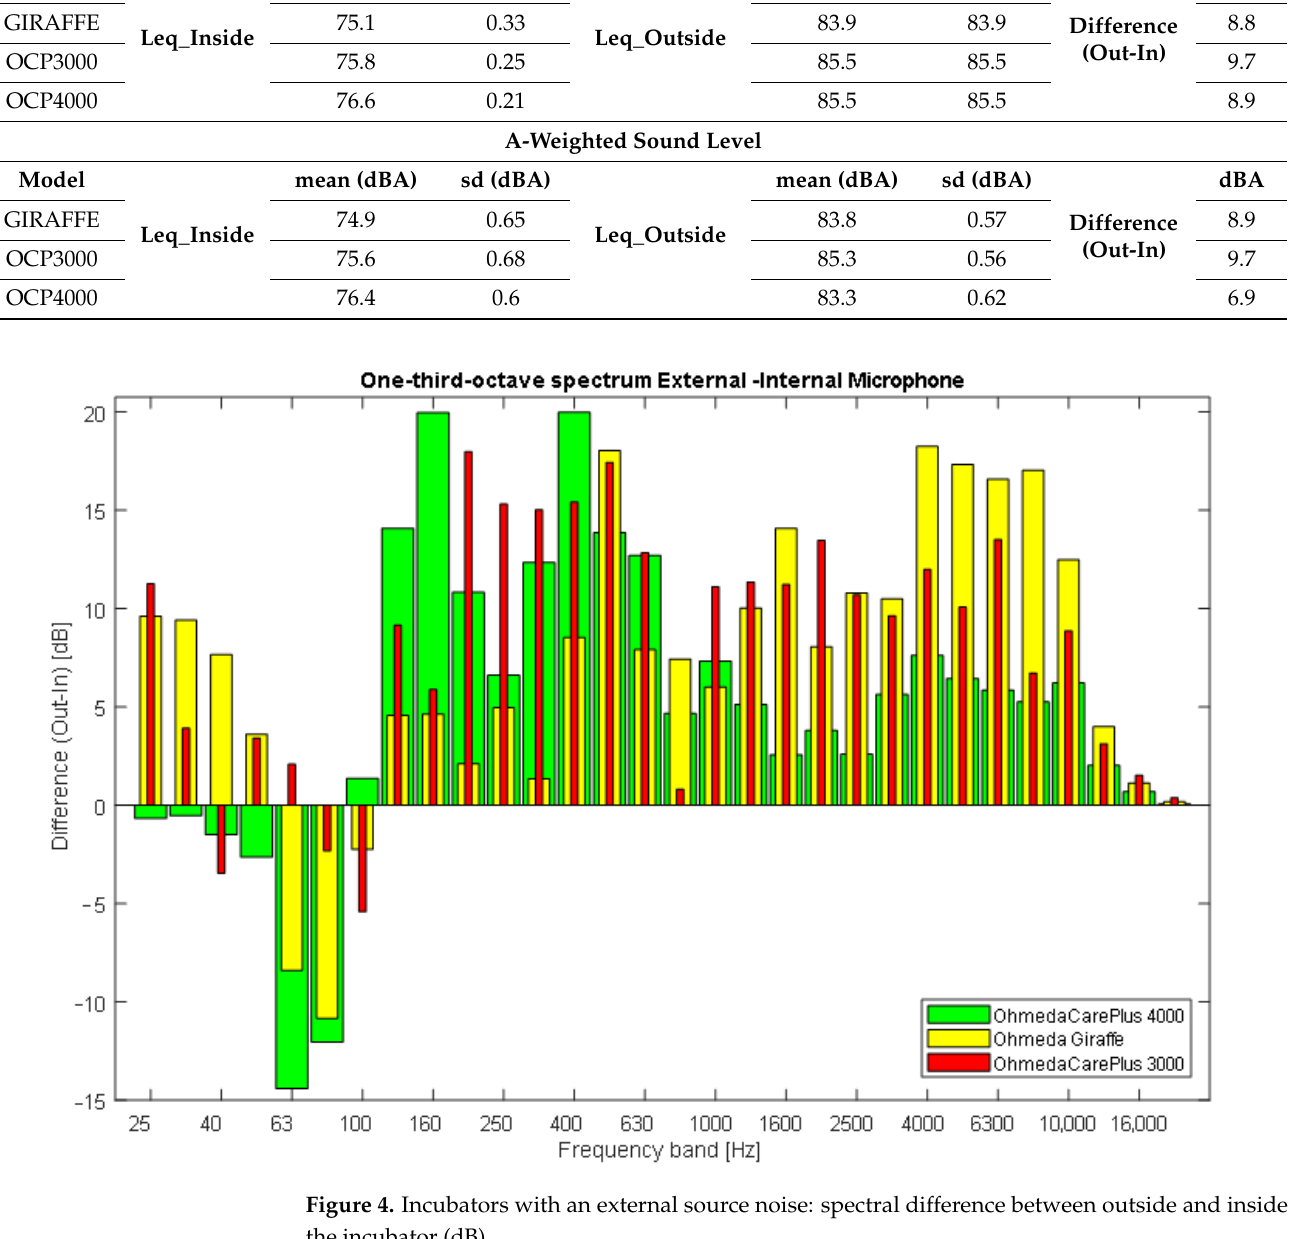
Figure 5. Frequency-dependent attenuation level for the worst situation (Mean–StdDev). All tests performed to compare values between incubators (Kruskal–Wallis and Mann–Whitney) showed p -values < 0.05. This indicates, as is expected, that there are no significant differences between incubator models.